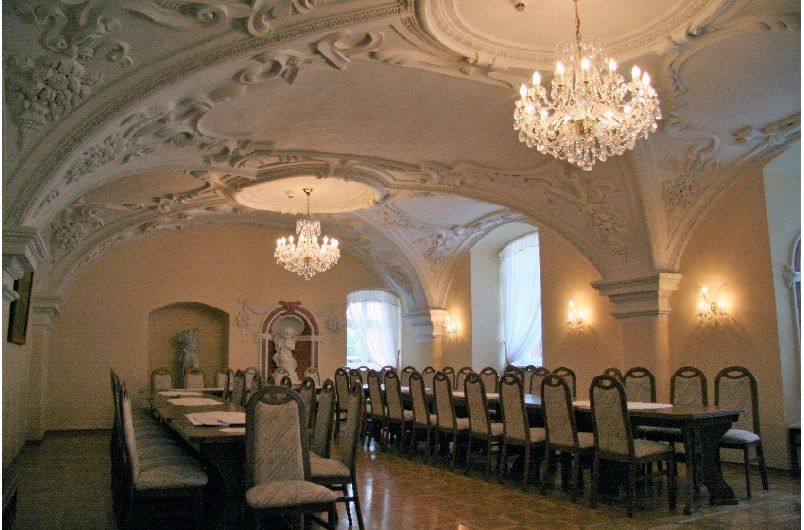
Figure 12. Prószków castle: interior of the ceremonial room called the “Knights Hall”; photo by the Figure 12. Pr ó szk ó w castle: interior of the ceremonial room called the “Knights Hall”; photo by authors. the